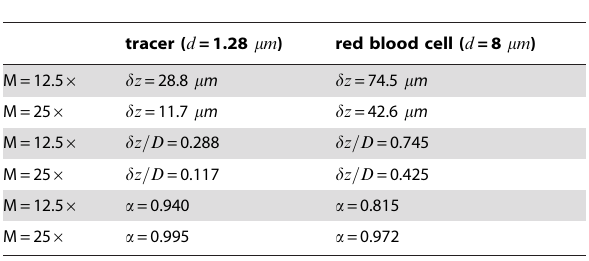
Table 1. Overview of imaging